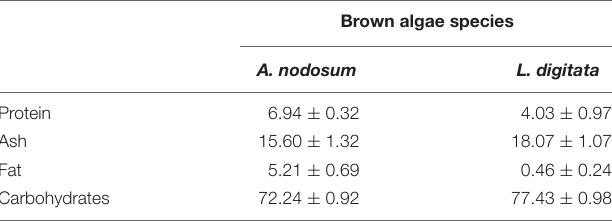
TABLE 1 | Proximate analysis of A. nodosum and L. digitata collected from Akureyri and Husavik, Iceland, respectively. Brown algae